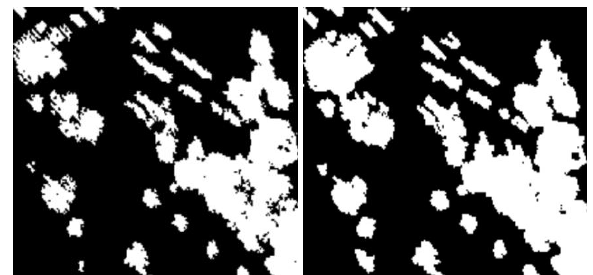
Figure 6. Examples of classified LiDAR points using LiDAR data only (left) and fused LiDAR data and NDVI (right).